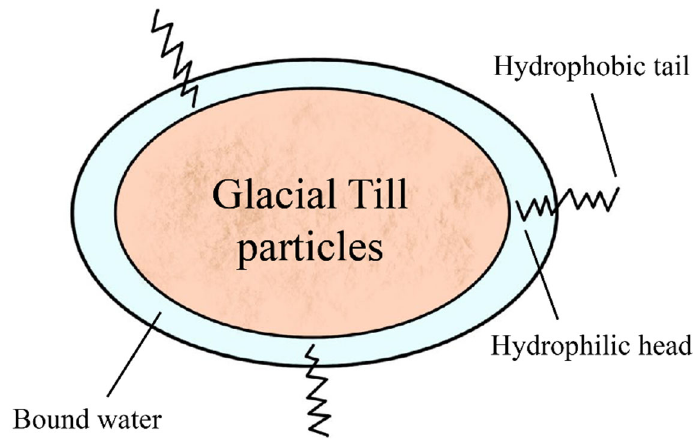
Figure 12. Schematic diagram of cation exchange.